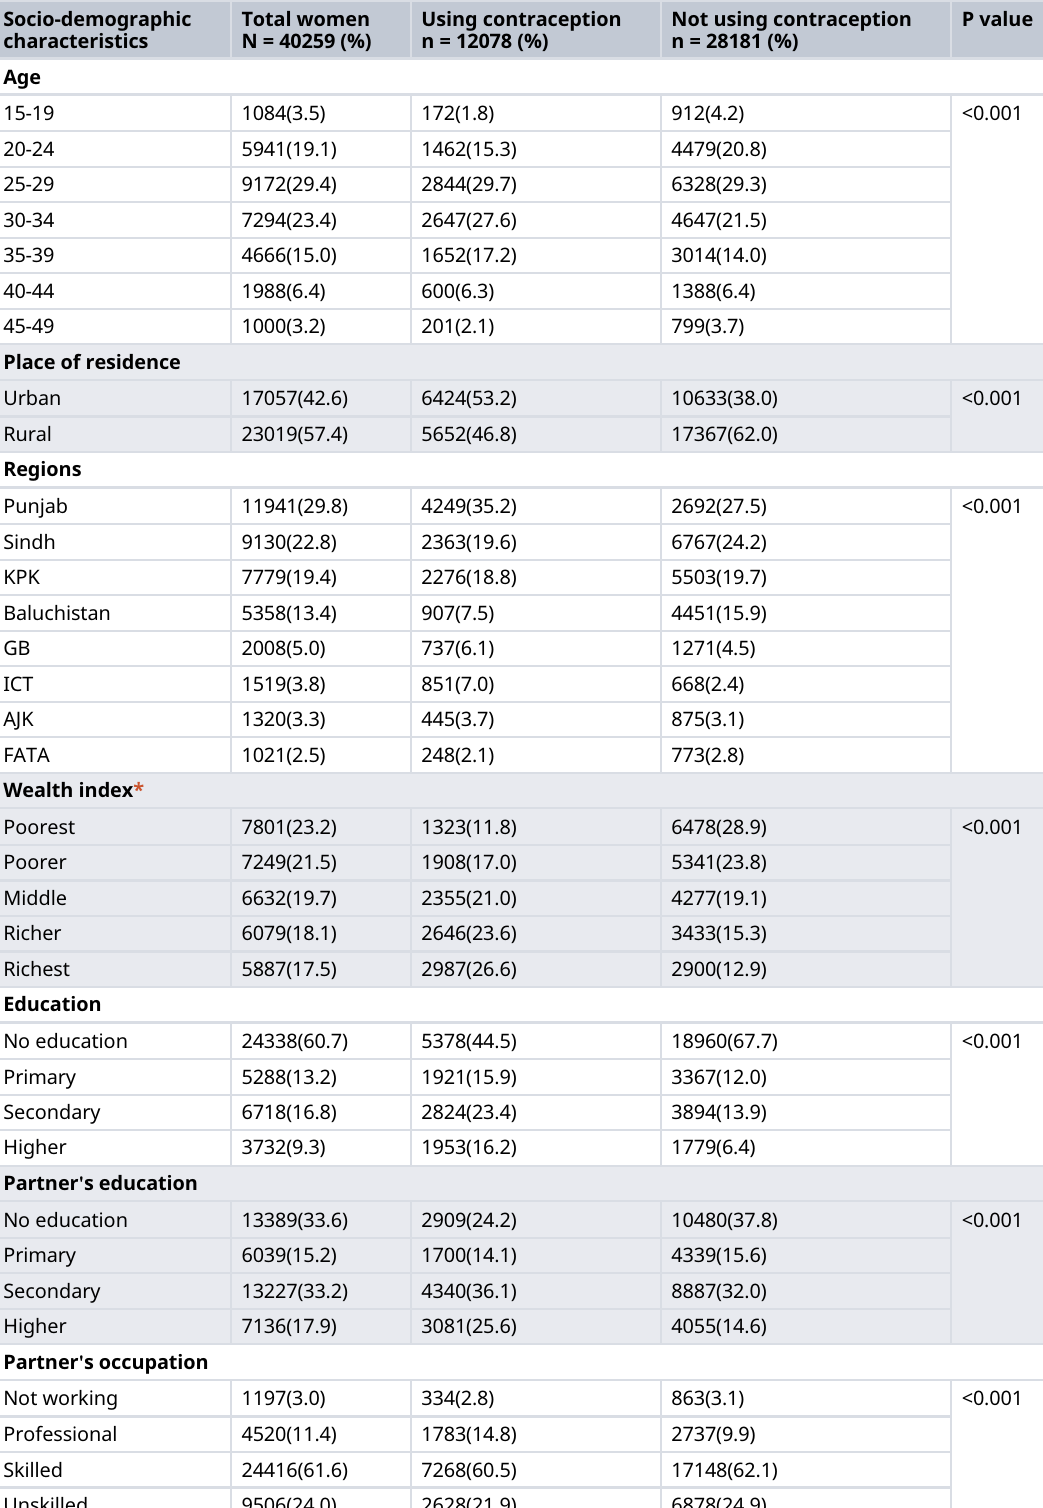
Table 1. Sociodemographic characteristics of women with respect to contraception usage from 1990-2018. Socio-demographic